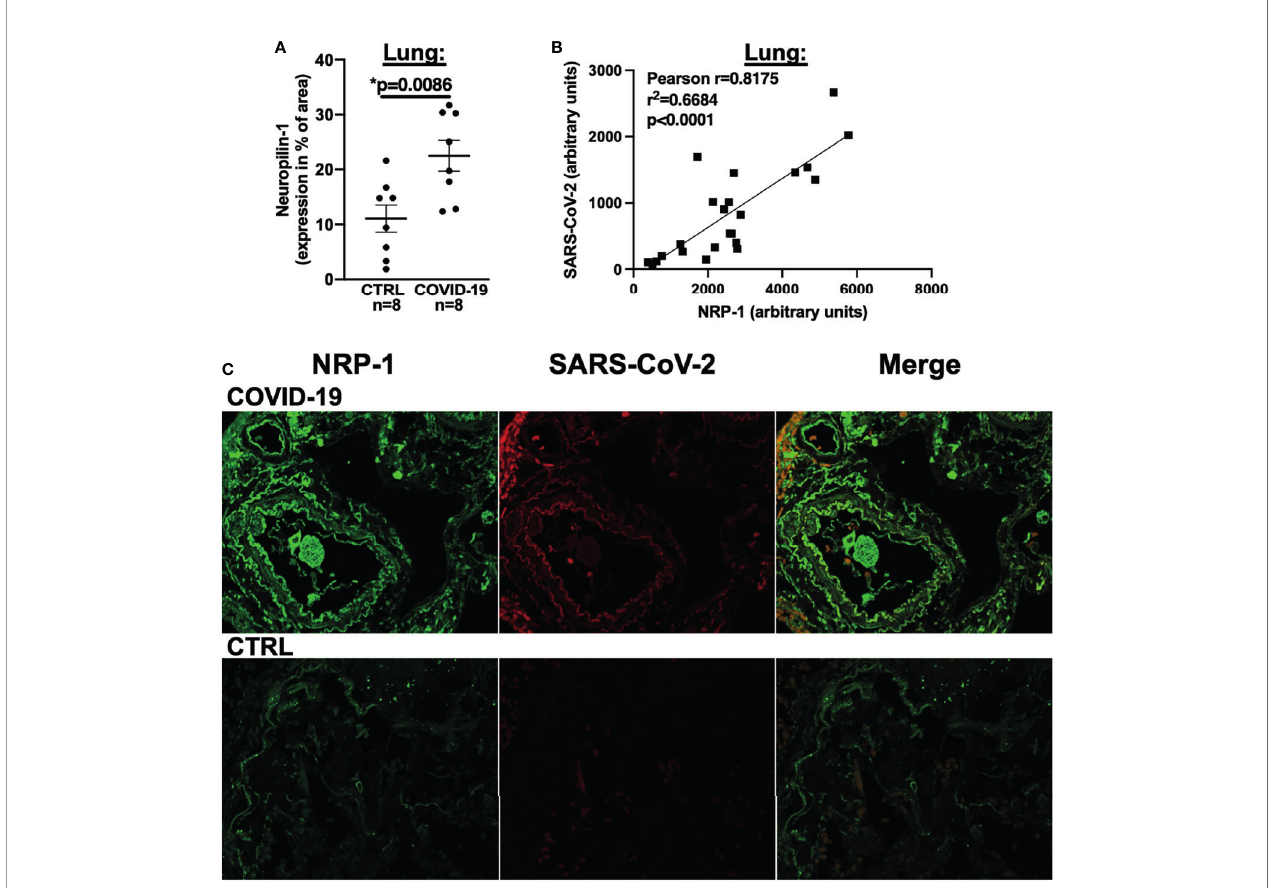
FIGURE 4 | NRP-1 expression is increased in the lungs of deceased COVID-19 patients and correlates with the amount of SARS-CoV-2 nucleocapsid. (A) Mean ± SEM NRP-1 expression (as % of area) measured by immuno fl uorescence in lung sections. Compared to control, there was a signi fi cant increase in NRP-1 immuno fl uorescence in the lungs of deceased COVID-19 patients (Student ’ s t-test). (B) Correlation analysis with linear regression of NRP-1 and SARS-CoV-2 nucleocapsid immuno fl uorescence in lung sections. There was a strong and signi fi cant correlation between the amounts of NRP-1 and SARS-CoV-2 nucleocapsid detected in the lungs of the deceased COVID-19 patients. (C) Original immuno fl uorescence stainings of NRP-1 and SARS-CoV-2 (and merged immuno fl uorescence channels) in lung sections from a patient with severe COVID-19 and CTRL (representing the full region of interest used for